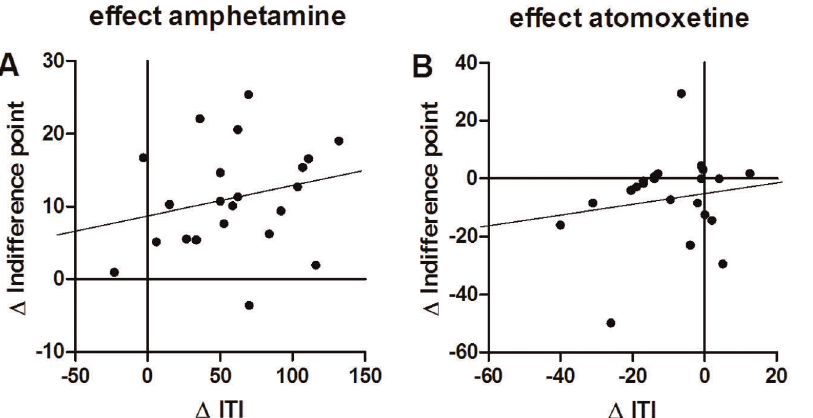
Figure 3. Correlation between impulsive choice and action after pharmacological manipulations in rats. In rats (n=22), there was no correlation between the effects of (A) amphetamine (0.5 mg/kg, r=.22) and (B) atomoxetine (1 mg/kg, r=.21) on the two impulsivity measures: the D indifference point (=drug challenge minus vehicle) of the delayed reward task and the D premature responses (=drug challenge minus vehicle) in the 5-choice serial reaction time task did not correlate.